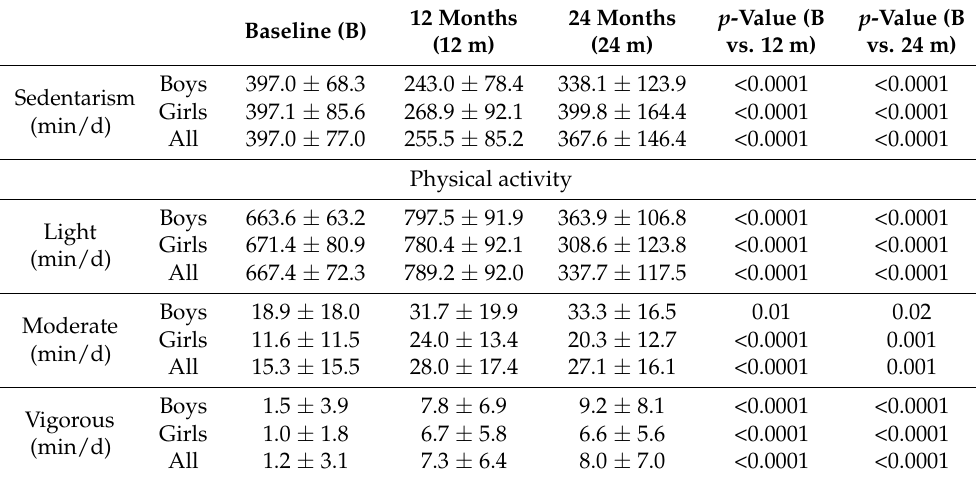
Table 4. Physical activity measured at baseline conditions, and after 12 months and 24 months of intervention in the total study population and by gender. (min/d: minutes/day). p -value < 0.05 is significantly